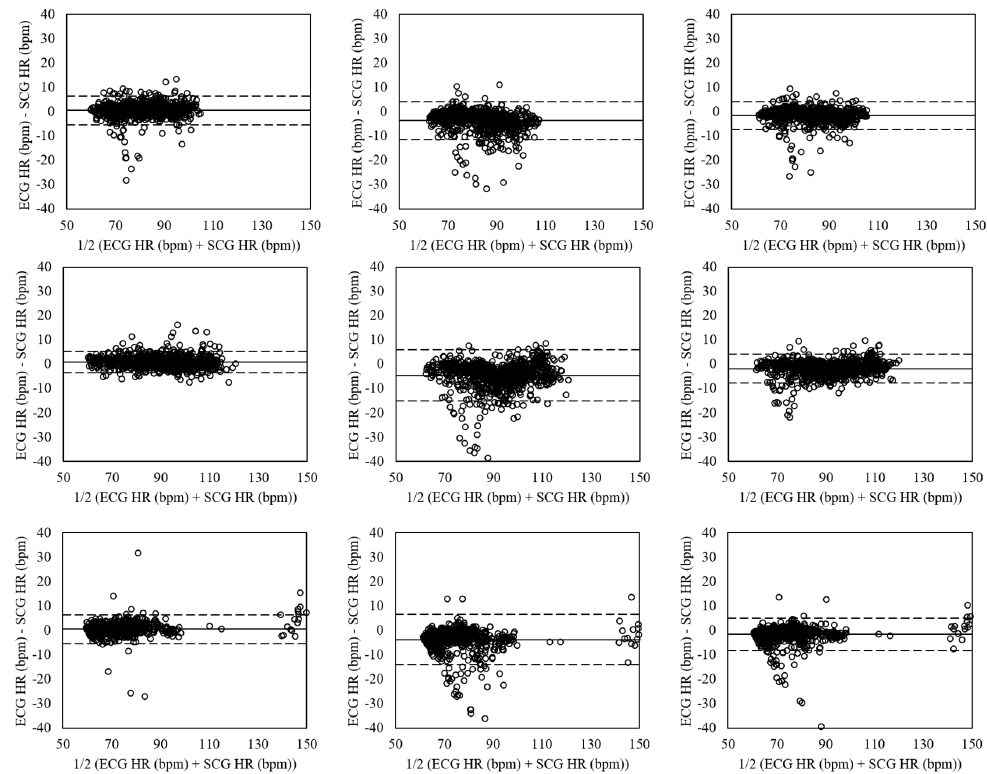
Figure 7. Bland-Altman plots of heart rates estimated from SCG and ECG by CNNs in relaxed condition for sitting ( Left ), standing ( Mid ), and supine ( Right ) postures based on the VGG-16 without data augmentation ( Top ), VGG-19 with data augmentation ( Mid ), and ensemble network ( Down ). The lines are the mean errors and 95% LOA.